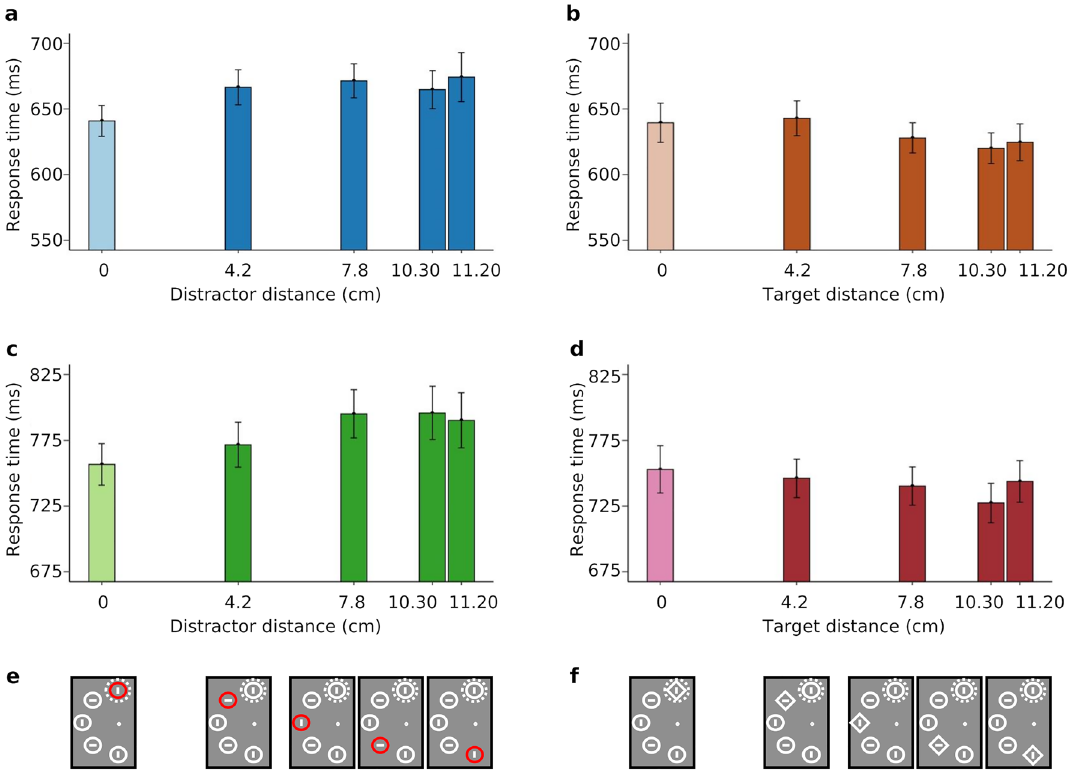
Figure 3. Response time results plotted by distance to the high-probability location, separately for the fixed- feature task (top row) and the mixed-feature task (bottom row). ( a , c ) Bar graphs show mean response times as a function of the distance of the distractor to the high-probability location (distance 0), with the distractor presented at the high-probability location (light blue and green) or the low-probability locations (dark blue and green). ( b , d ) Bar graphs show mean response times as a function of the distance of the target to the high- probability distractor location (distance 0) in distractor-absent trials, with the target presented at the high- probability distractor location (light orange and pink) or the low-probability distractor locations (dark orange and pink). Error bars show standard errors of the means. ( e , f ) Examples of the visual search displays illustrate the corresponding distractor location ( e ) and the location of the target ( f ) in a trial (the displays are only partially shown). The high-probability location is shown on the top vertical and indicated by the dotted were slower for targets presented at the high-probability location ( M = 696.23 ms, SEM = 13.75 ms) compared to targets presented at the low-probability locations ( M = 683.46 ms, SEM = 11.47 ms; F (1,58) = 6.17, p = 0.016, η p 2 = 0.096; see Fig. 2b), and faster in the fixed-feature ( M = 634.01 ms, SEM = 9.34 ms) than in the mixed-fea- ture task ( M = 745.69 ms, SEM = 11.36 ms) F (1,58) = 30.37, p < 0.001, η p 2 = 0.34. The interaction was not significant F (1, 58) = 0.13, p = 0.717, η p2 = 0.002.